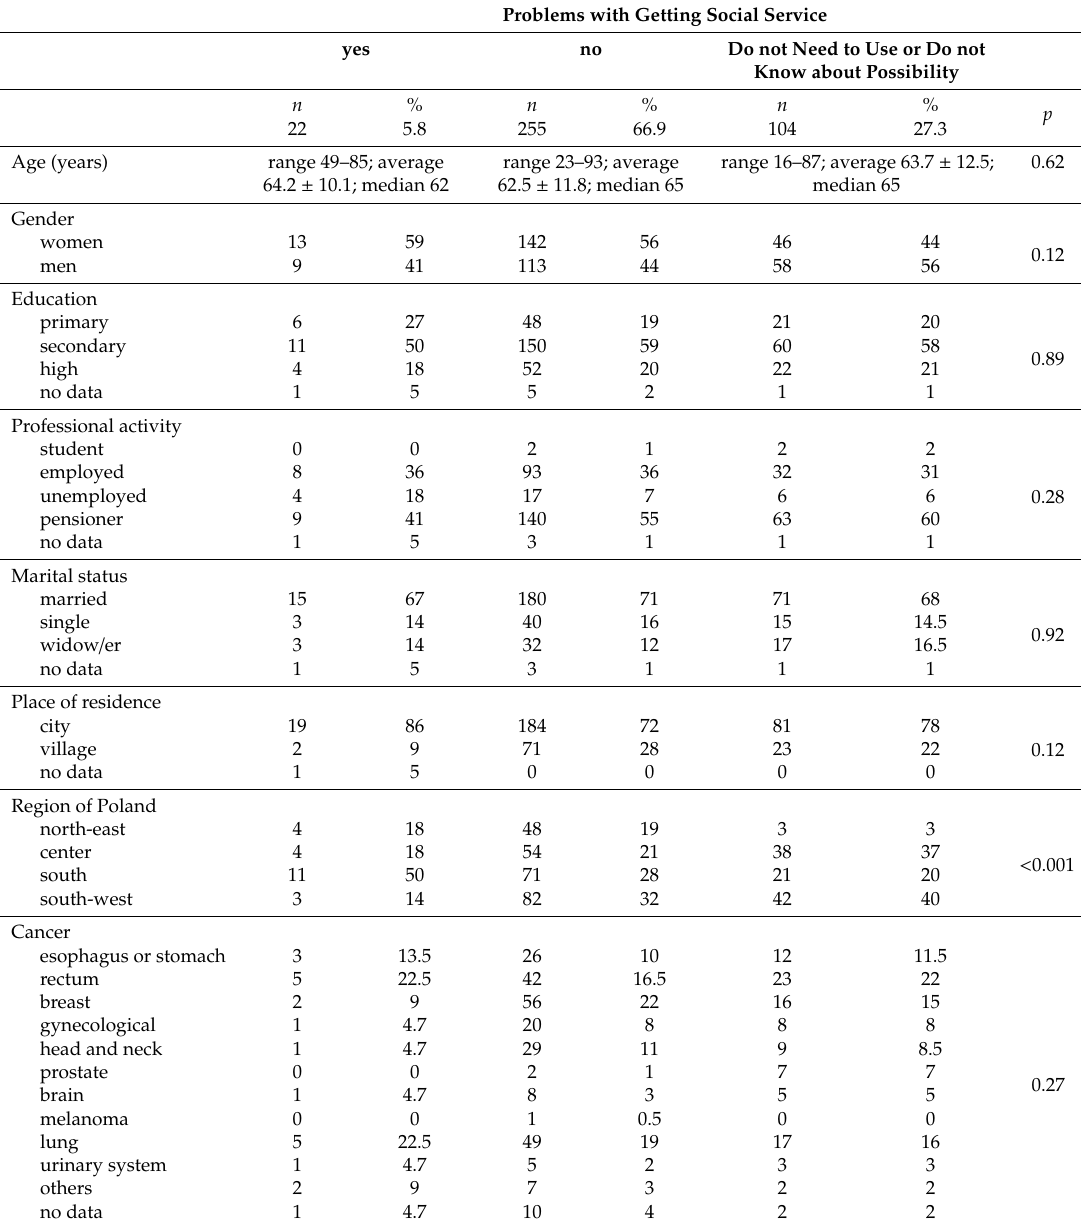
Table 4. Problems with getting social service according to various